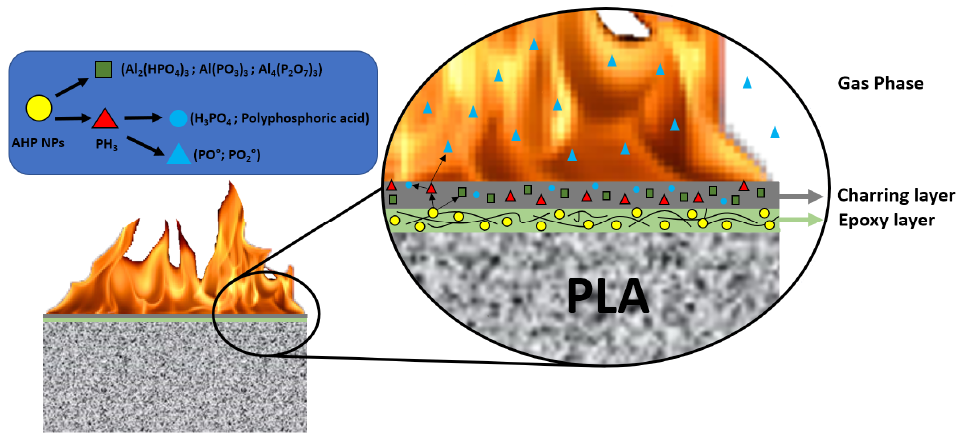
Figure 11. Schematic illustration for the flame-retardant mechanism of PLA/Epoxy-AHP NPs com- posites.